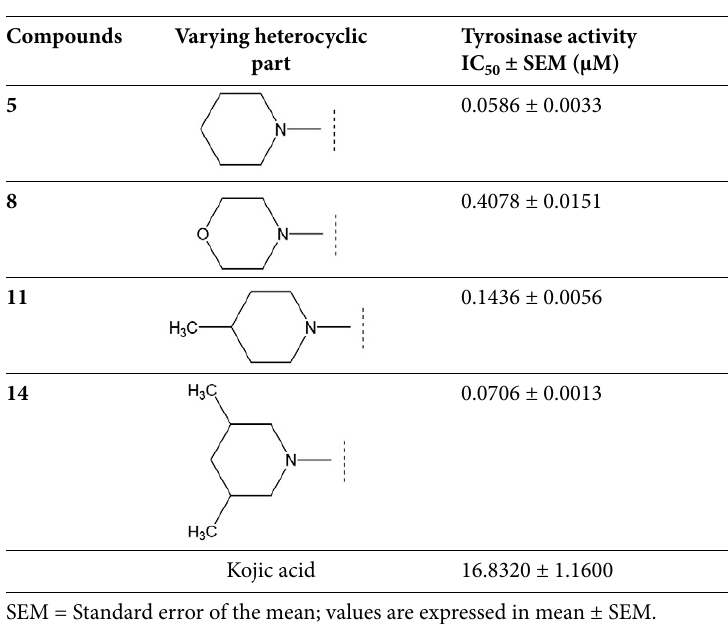
Table 1. Tyrosinase inhibitory and hemolytic activity of tri-heterocyclic compounds.